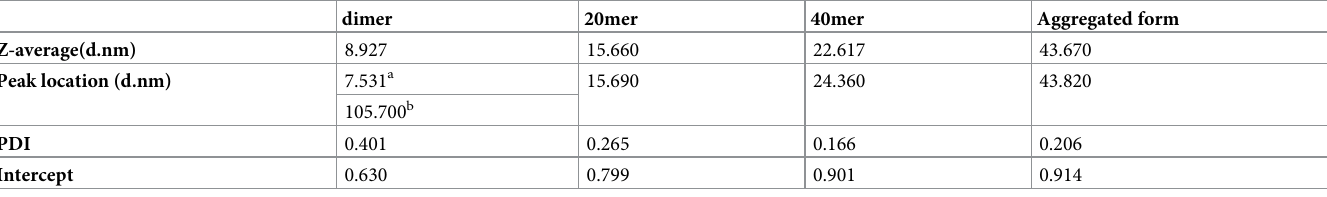
Table 1. The DLS measurement profiles of all four forms of hPER2c resulted from SEC